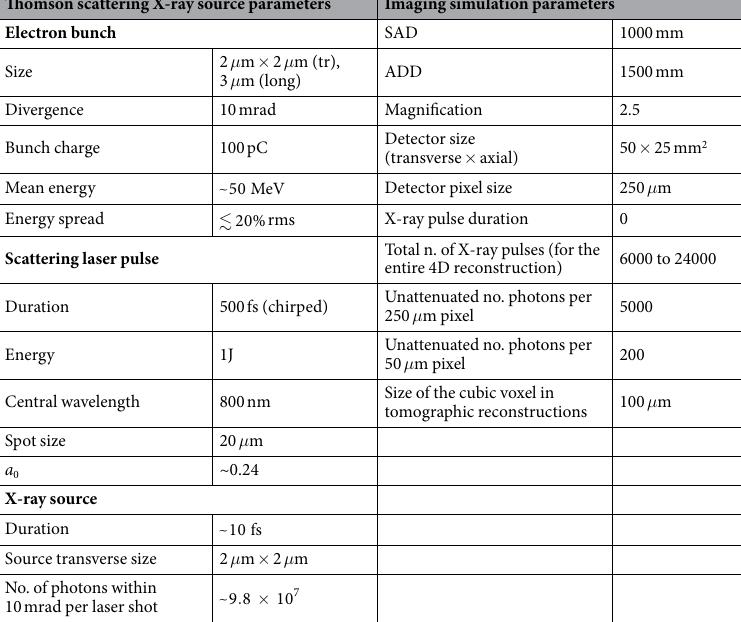
Table 2. Left column : main parameters relevant for the operating regime of the X-ray source; the electron bunch and scattering laser pulse figures were used as input of the Thomson scattering simulation code TSST. More parameters related to a possible LWFA regime able to provide the required electron bunch are given in the Supplementary Materials. Right column : parameters of the numerical simulation with the 4D mouse chest phantom (SAD: Source to axis distance; ADD: Axis to detector